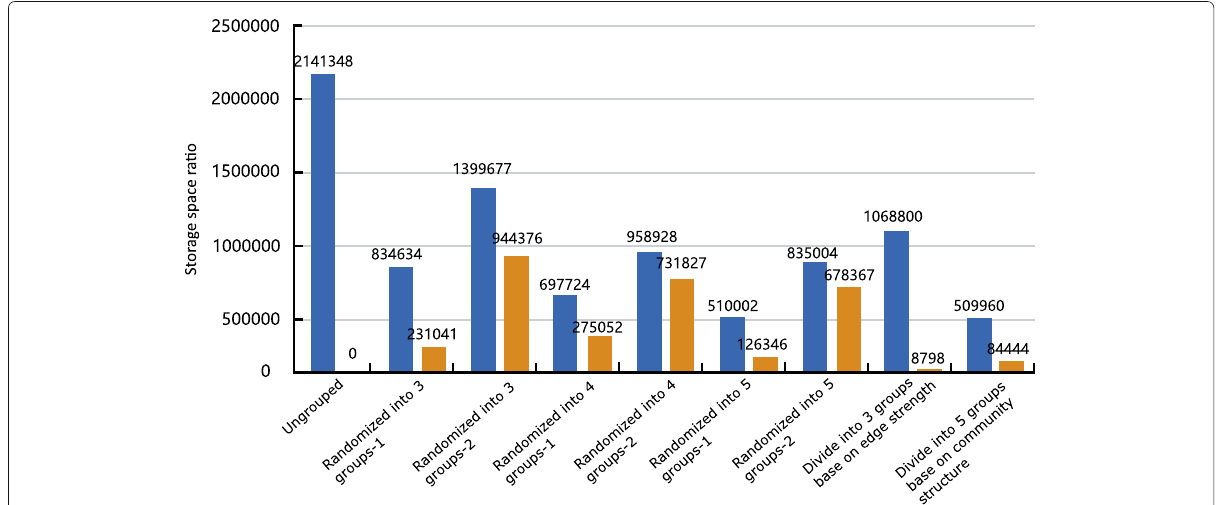
Fig. 4 Spatial statistics of different classification